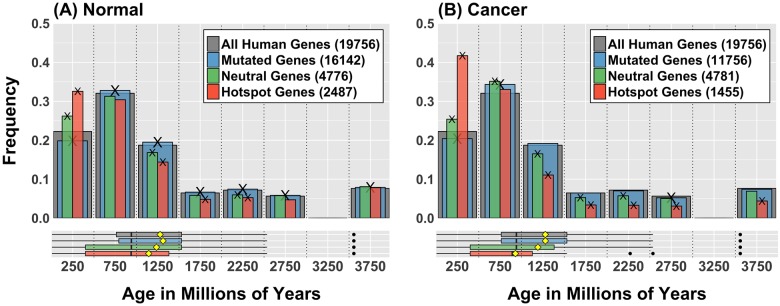
Mutational pattern in young genes is characterized by hot-spotting.(A) Age distribution of all genes mutated in normal samples data (blue), genes that have neutral level of mutation, as expected from a uniform random distribution (green) and genes in hotspots (orange). Grey bars represent the age distribution of all human genes. Numbers in legend are the sizes of each gene set. Cross marks (X) indicate the enrichment in that category is statistically significant according to a bootstrap test (BSQ < 1%, see Table 1). Boxplots in lower panel show distribution quartiles; black vertical lines are medians, yellow diamonds are means and black dots are outliers. (B) Equivalent plots for cancer data (ICGC release 19). In both plots when we observe the age distribution of genes involved in hotspots (orange), a very large proportion of them are very young (less than 500 MY). This suggests that the mutational activity that produces hot-spotting in the genome is preferentially hitting younger genes in spite of the fact that they are generally under-represented in the sets of all observed mutations.